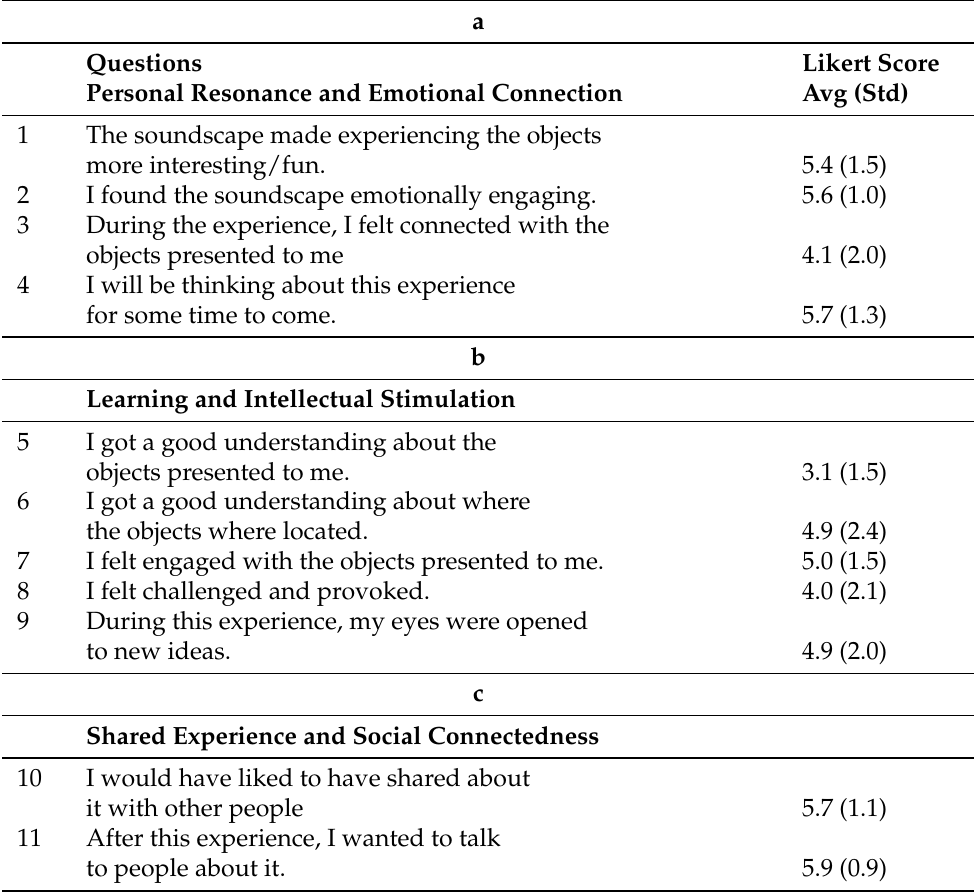
Table 3. Evaluation part